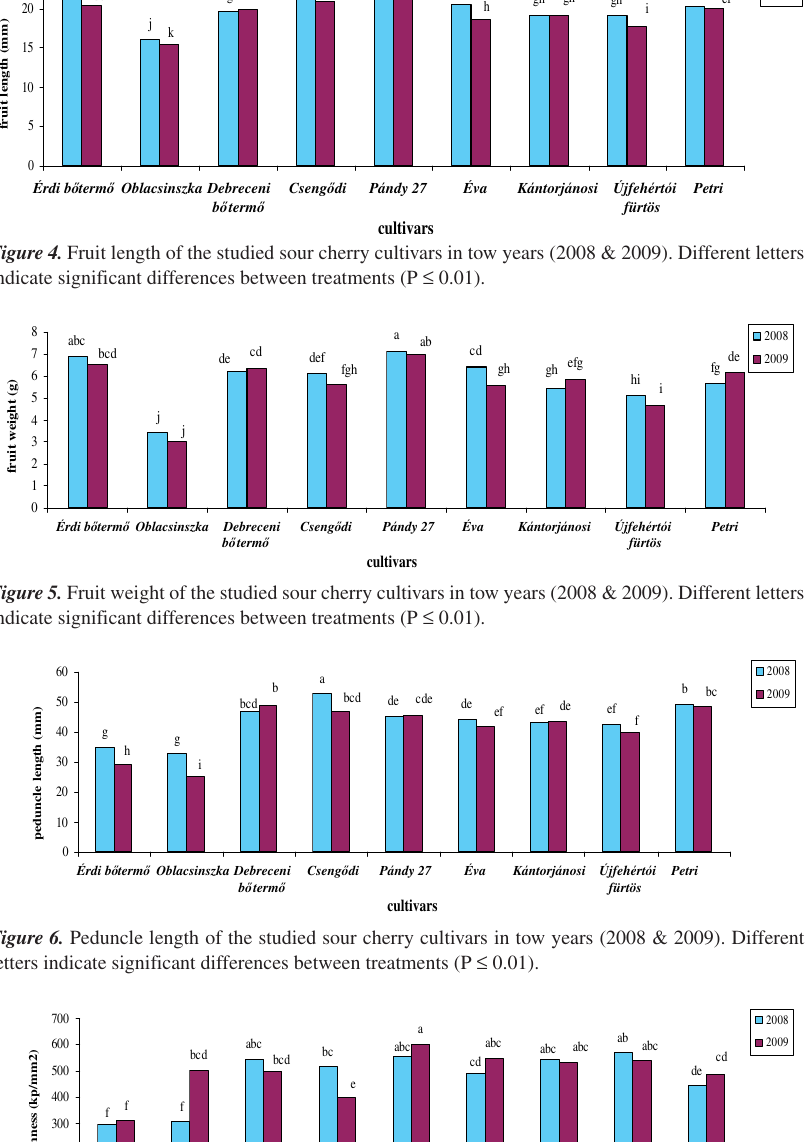
Figure 7. Flesh firmness of the studied sour cherry cultivars in tow years (2008 & 2009). Different letters indicate significant differences between treatments (P